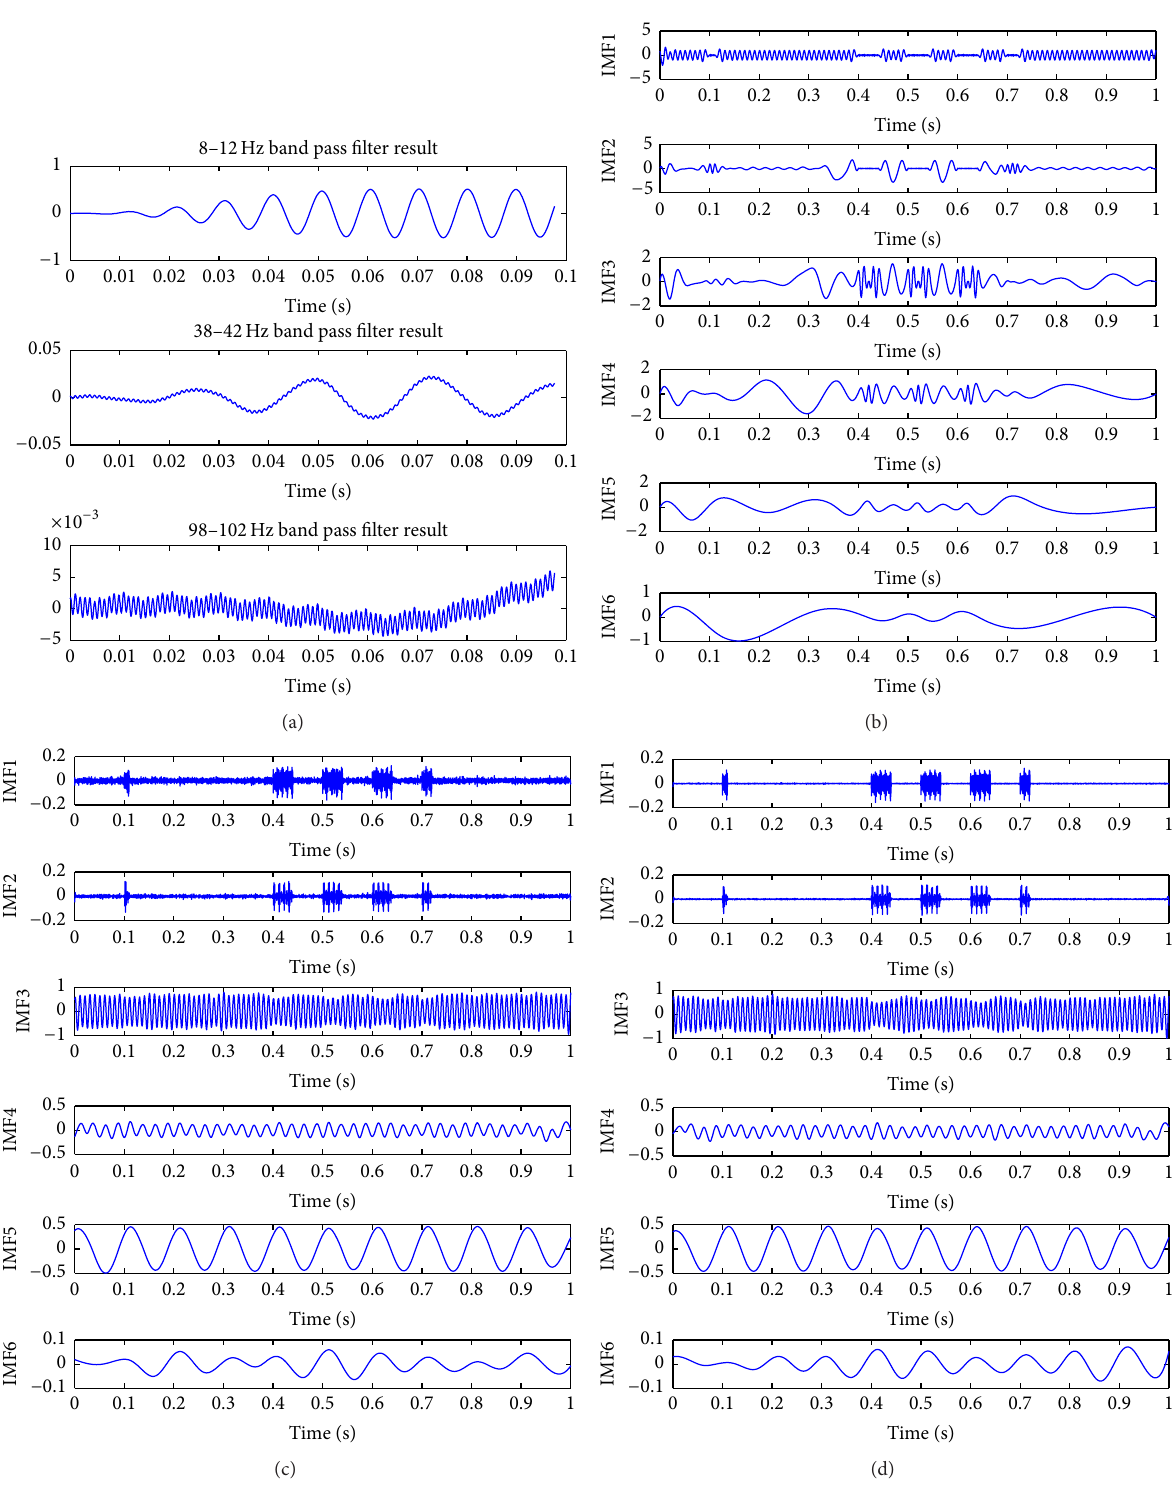
Figure 2: (a) The result of band pass filter. (b) The result of EMD. (c) The result of EEMD. (d) The result of